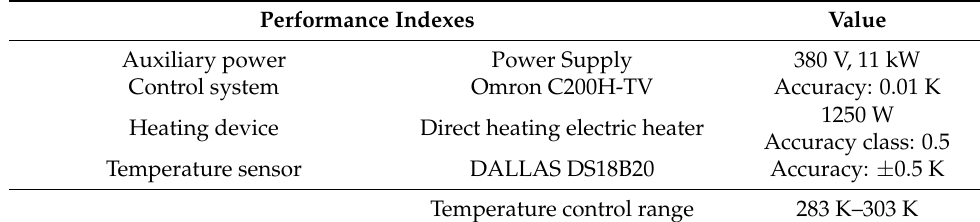
Table 3. The performance indexes of the IMMCB-1818X testing